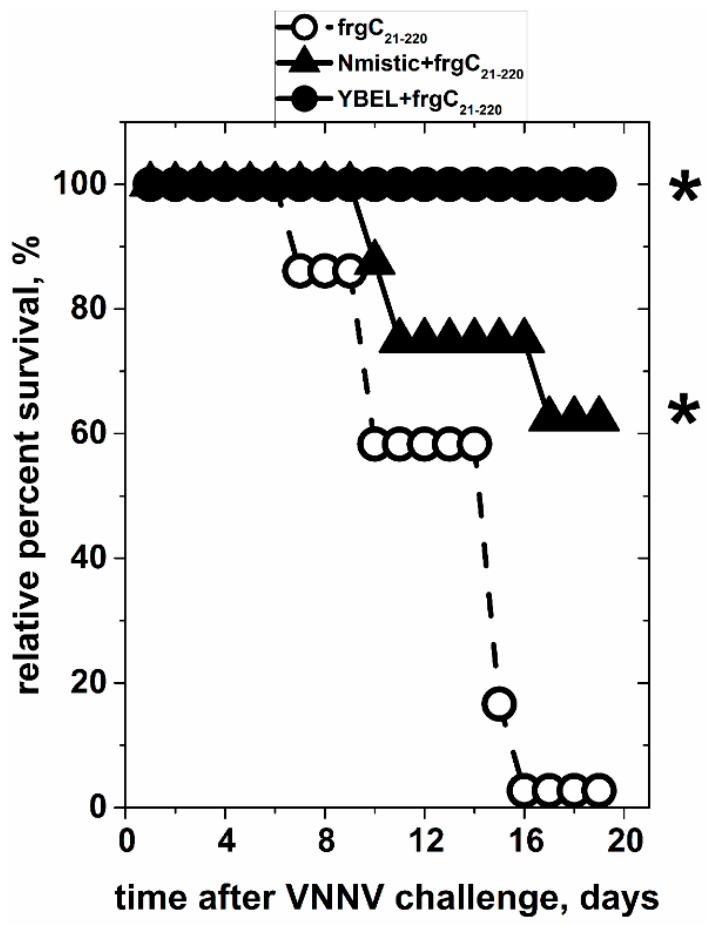
Figure 7. Protection to VNNV challenge of sea bass juveniles after intraperitoneal injection of frgC 91–220 , Nmistic + frgC 91–220 or YBEL + frgC 91–220 BLR(DE3) spinycterins.